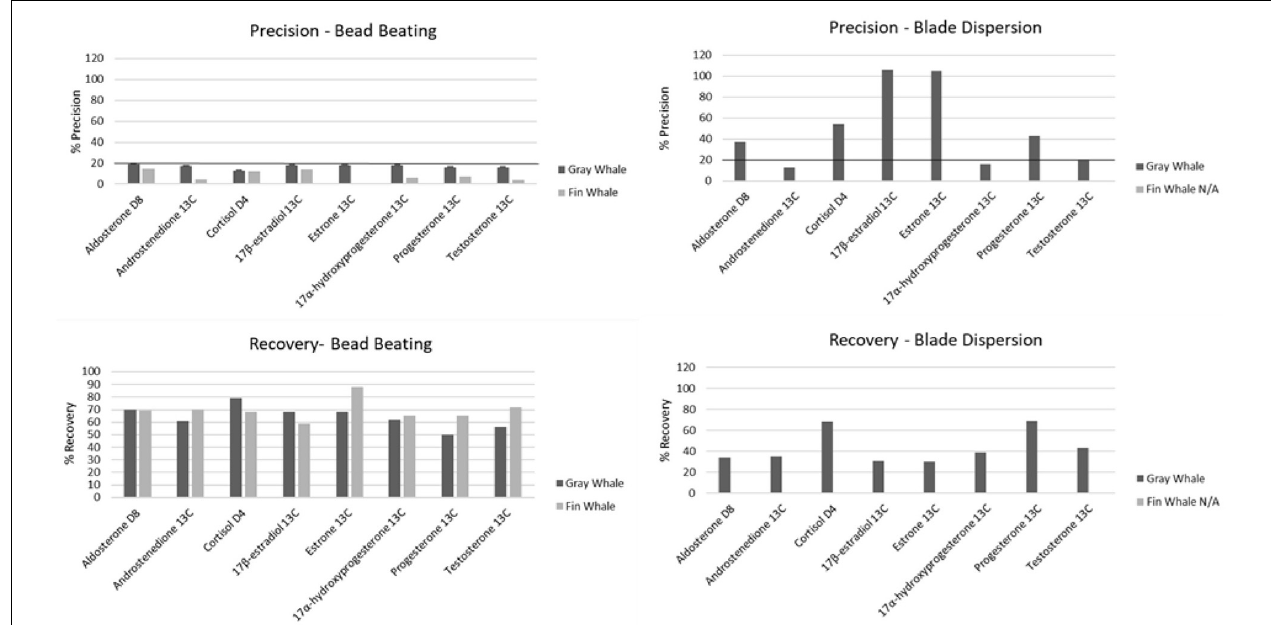
FIGURE 2 | Precision % and recovery values obtained with bead beating (Fast Prep 24) and blade dispersion (Polytron) homogenization methods ( n = 7). Line represents the 20% cut off value for precision.